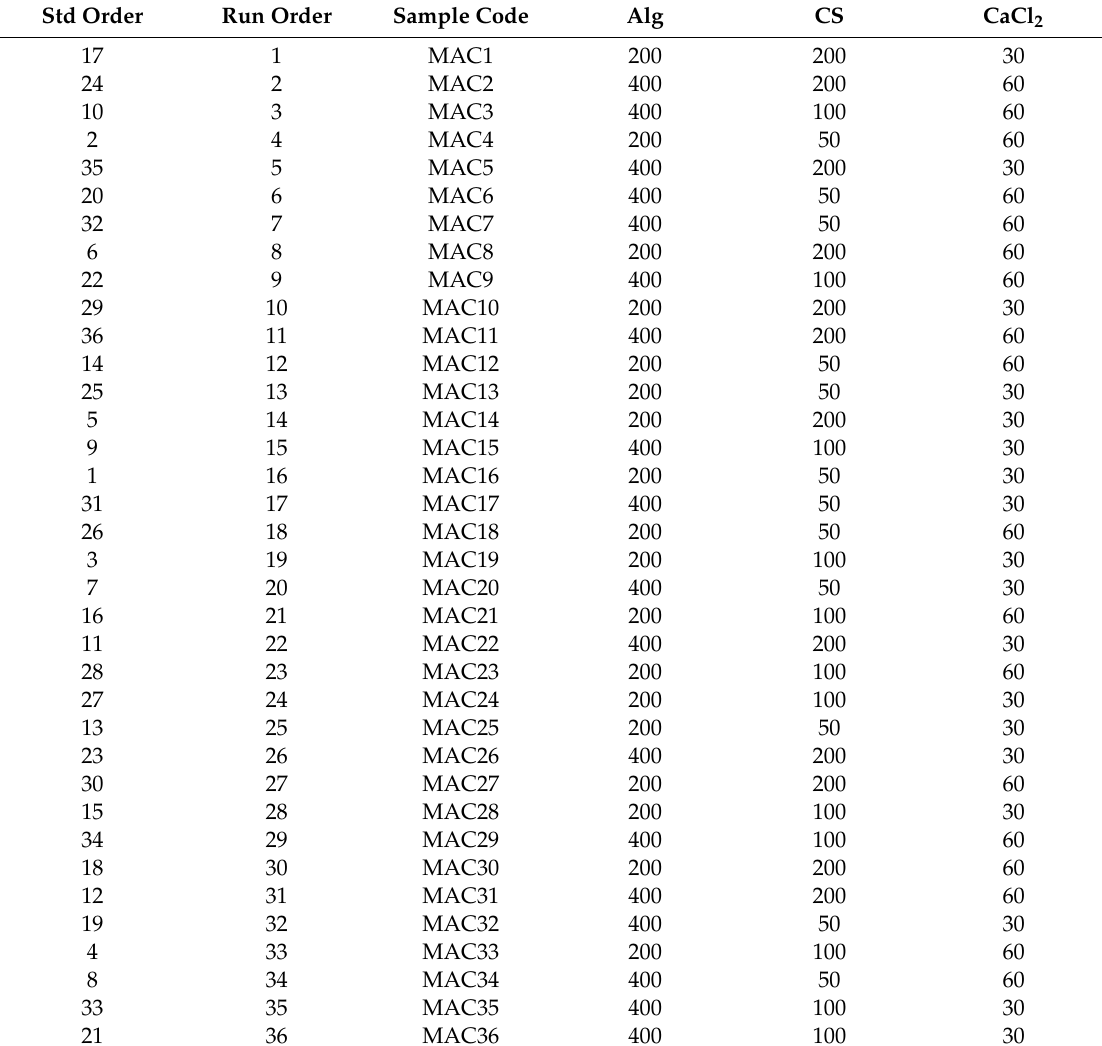
Table 2. Composition of